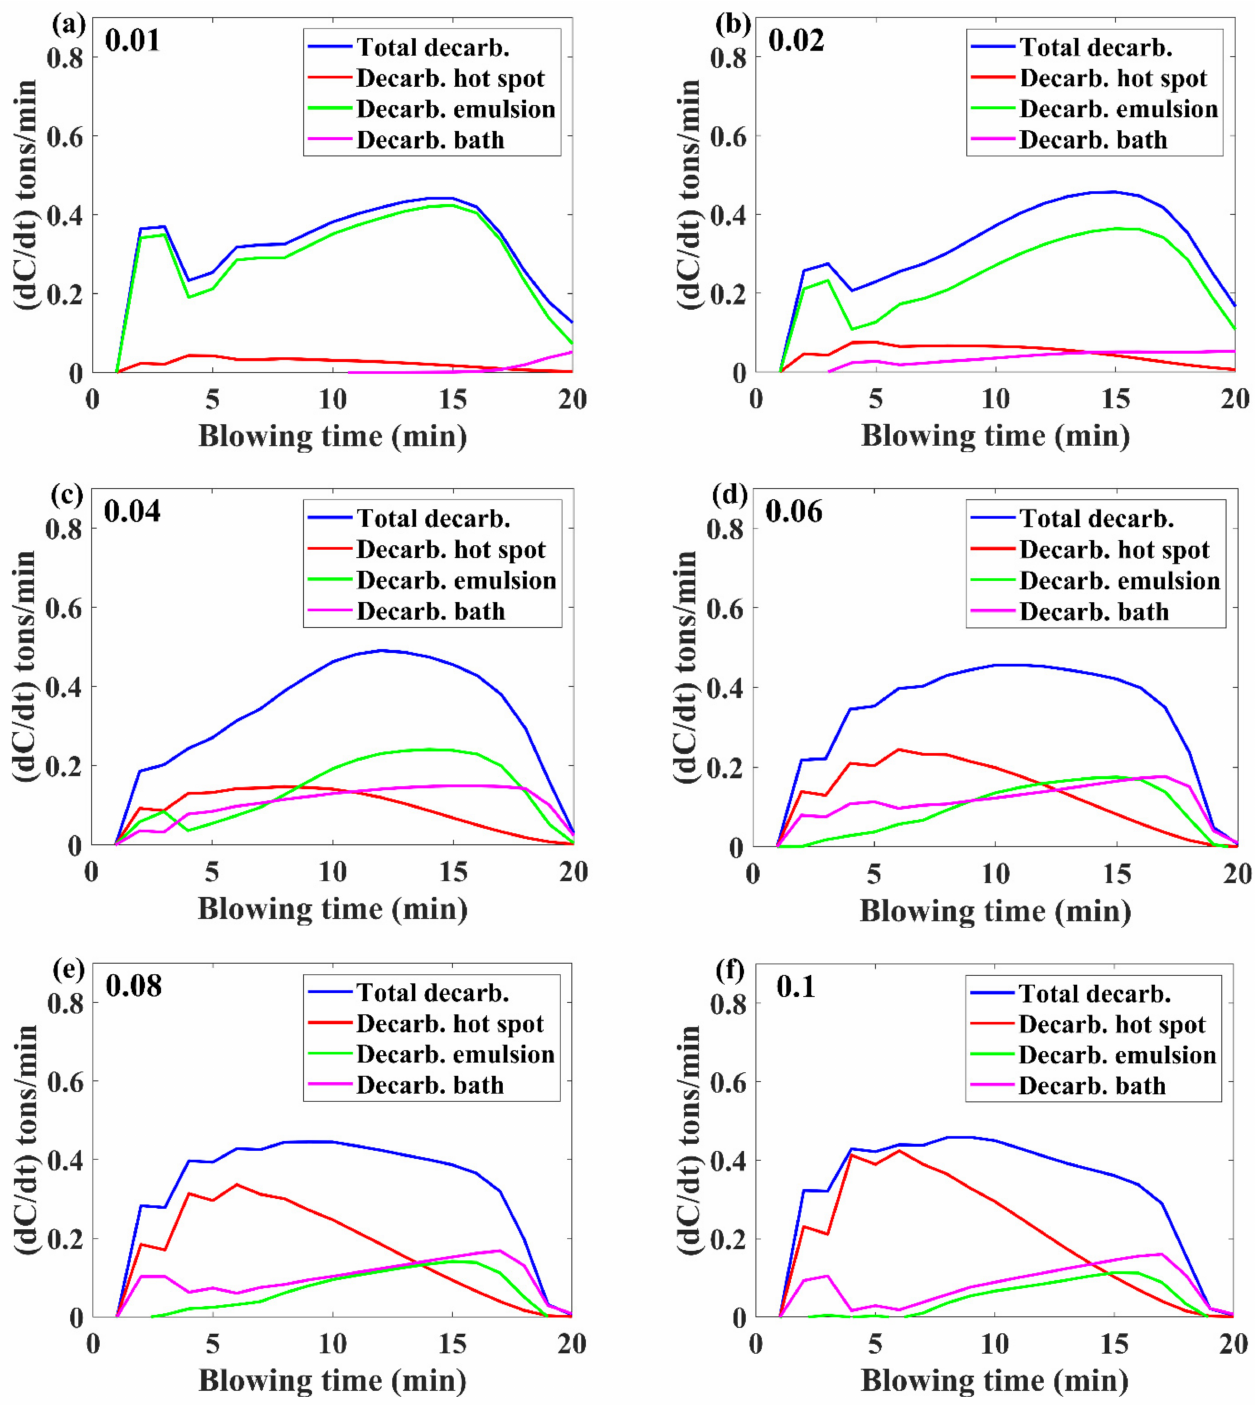
Figure 2. Comparison of rates of total decarburization (blue), decarburization in hot-spot zone (red), decarburization in emulsion zone (green), and decarburization in metal bath (magenta) with blowing time at ( a ) 0.01 inialpha, ( b ) 0.02 inialpha, ( c ) 0.04 inialpha, ( d ) 0.06 inialpha, ( e ) 0.08 inialpha, and ( f ) 0.1 inialpha. Input details for the present study of thermodynamic modelling are shown in Table